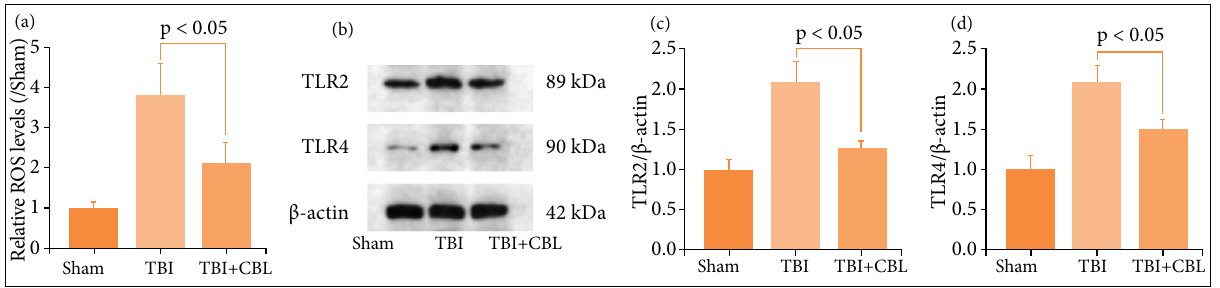
Figure 5 - CBL regulates neuroinflammation and apoptosis by modulating the TLR signaling pathway after TBI. (a) The levels of ROS by the DCF-DA method. (b) The expression of TLR2 and TLR4 in the brain cortex of mice after TBI was determined by Western blotting. (c-d) Quantification of TLR2 and TLR4 in the brain cortex compared to the β-actin loading control. CBL significantly decreased brain cortex TLR2 and TLR4 expression after TBI (n = 6, p < 0.05; analysis of variance; mean ± SEM). Cerebrolysin decreases the levels of proinflammatory cytokines in traumatic brain injury patients To verify the anti-neuroinflammatory effect of CBL in TBI patients, we evaluated the expression levels of serum IL-1 β , IL-6, TNF- α , and NF- κ B in TBI patients. We measured the serum levels of IL-1 β , IL-6, TNF- α , and NF- κ B using ELISAs. The levels of proinflammatory cytokines were increased significantly after TBI, while the levels of proinflammatory cytokines decreased significantly after CBL treatment (Figs.